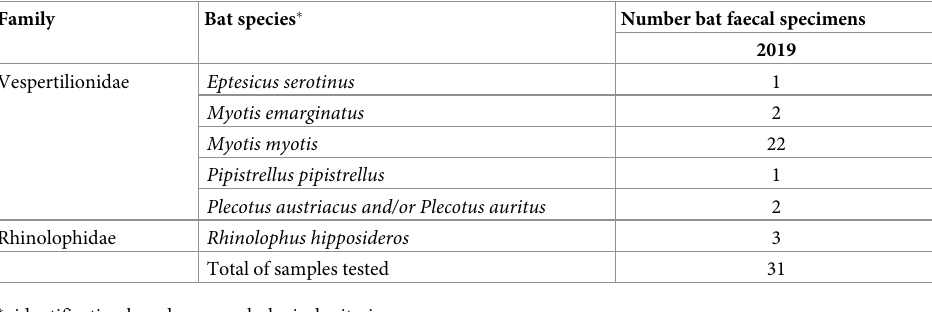
Table 3. Characteristics of the 31 bat faecal specimens included in the